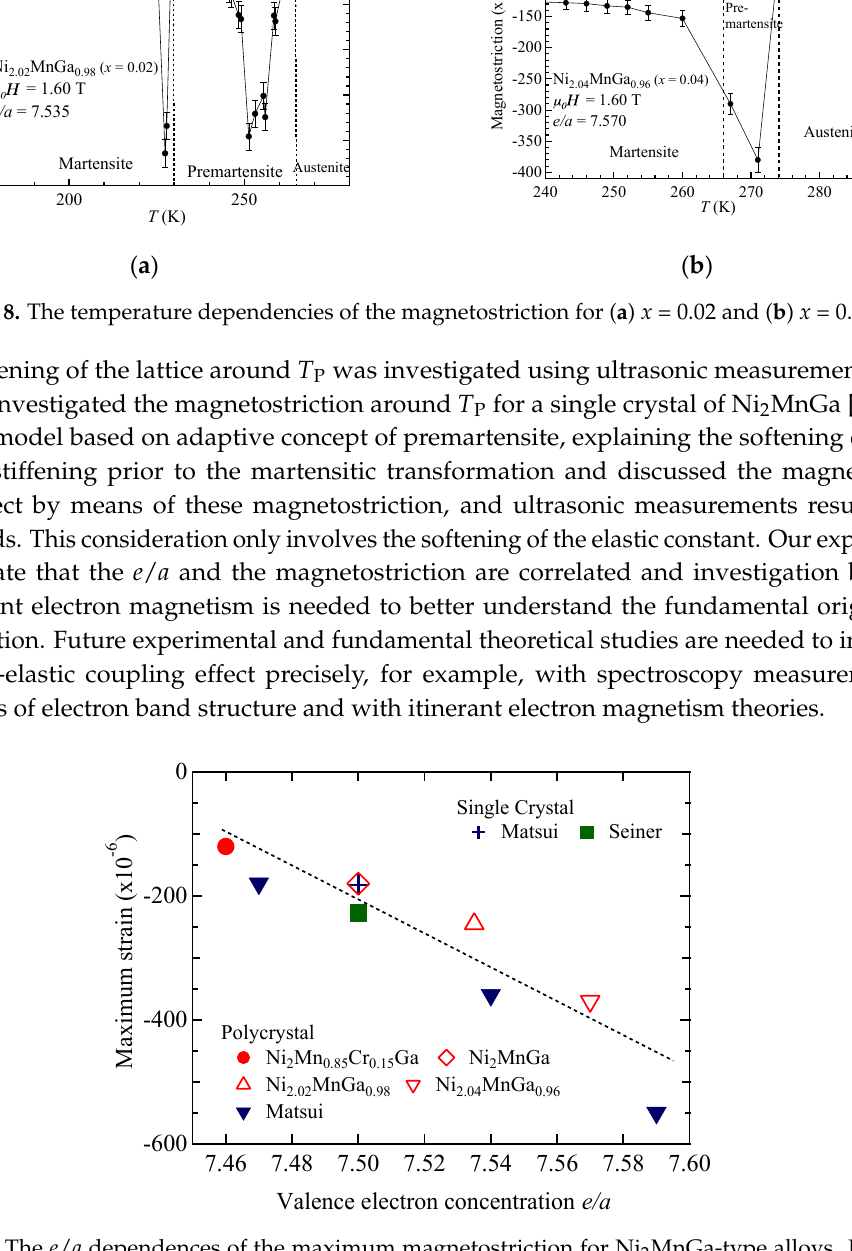
Figure 9. The e / a dependences of the maximum magnetostriction for Ni 2 MnGa-type alloys. Filled triangles: polycrystal, Matsui et al. [17,18]. Cross: single crystal, Matsui et al. [17]. Filled square: single crystal, Seiner et al. [33]. The dotted line is a fitted line.